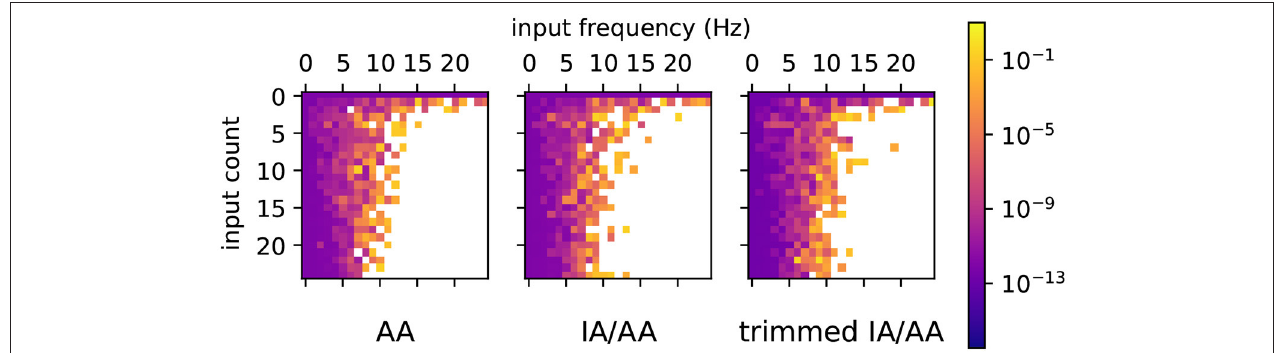
FIGURE 5 | Simulations of fan-in Morris-Lecar networks where each model had a different number of Poisson input neurons (0–24 neurons) and the inputs had different frequencies (0–24 Hz). Each tile shows the mean diameter of V over 500 simulated milliseconds, with warmer tiles indicating wider mean diameter. White tiles indicate that the range explodes at some point during the